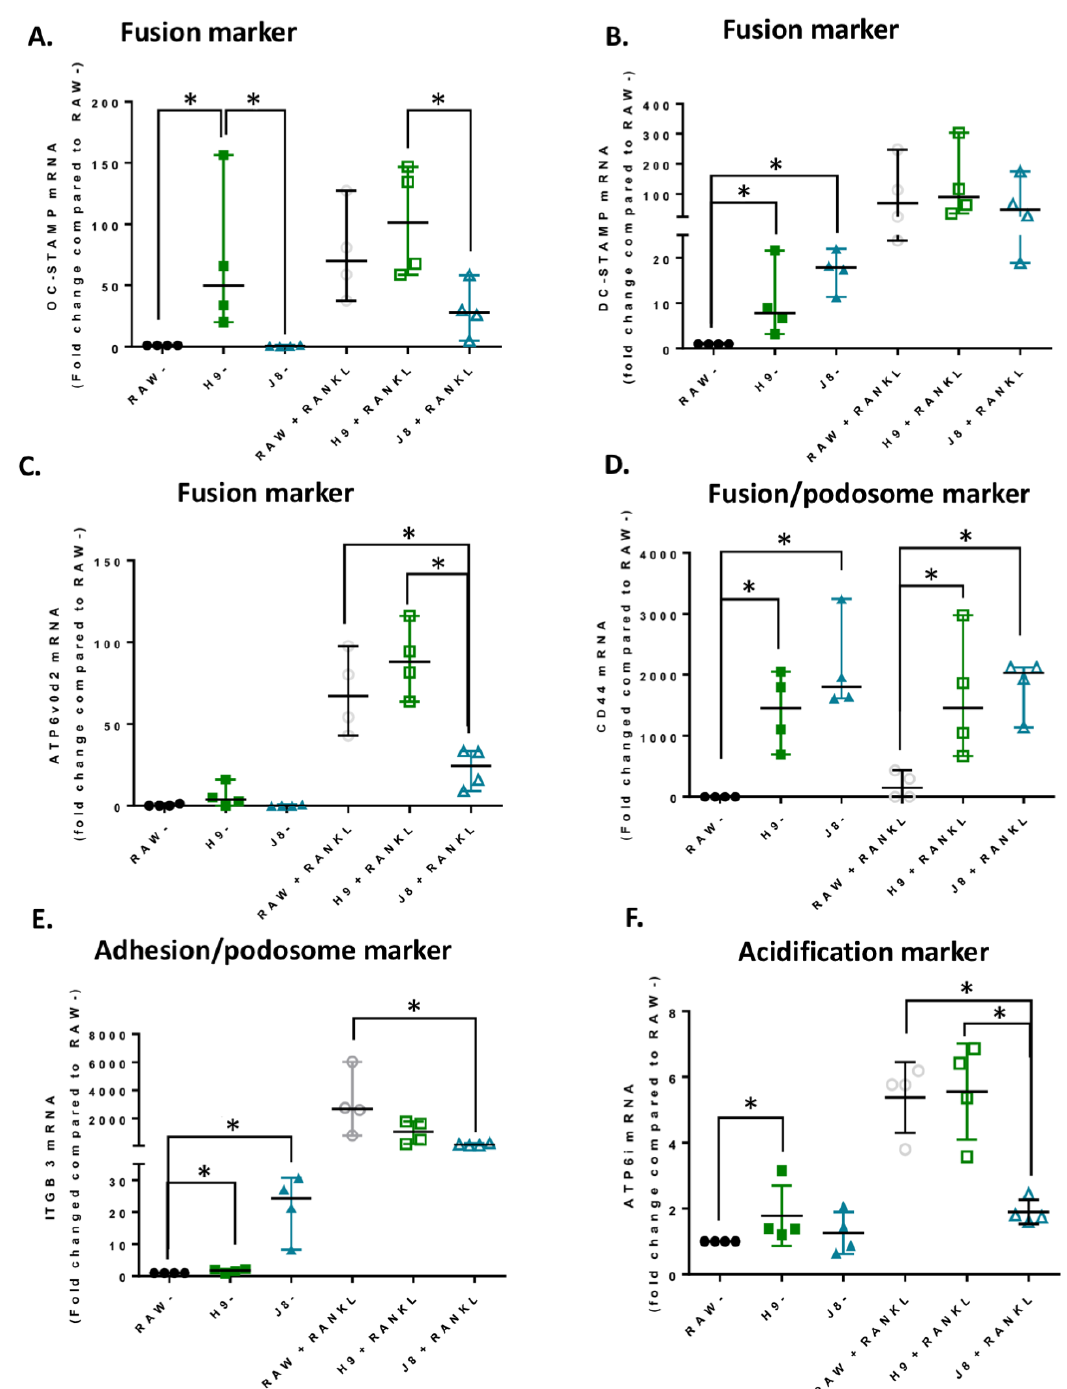
Figure 3. Osteoclast gene expression in RAW264.7 and sub-clones H9 and J8. RAW264.7, H9 and J8 were stimulated +/− 10 ng/mL RANKL for 4 days after which mRNA expression of osteoclast (OC) genes was measured ( n = 4). ( A ) OC-stamp mRNA, ( B ) ATP6v0d2 mRNA, ( C ) DC-stamp mRNA, ( D ) CD44 mRNA, ( E ) integrin b3 mRNA, ( F ) ATP6i mRNA, Data were analyzed using Mann-Whitney U test. * p < 0.05. Values are given as median +/− range.